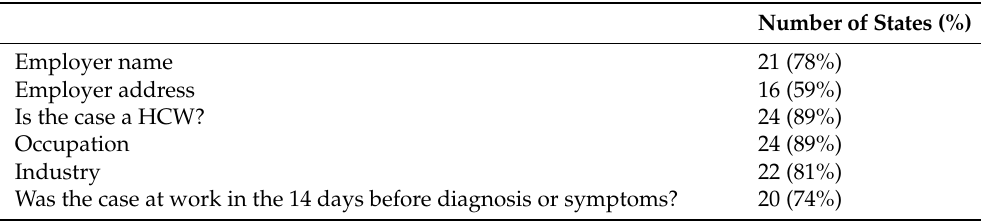
Table 1. Number of states collecting employment-related data ( n =